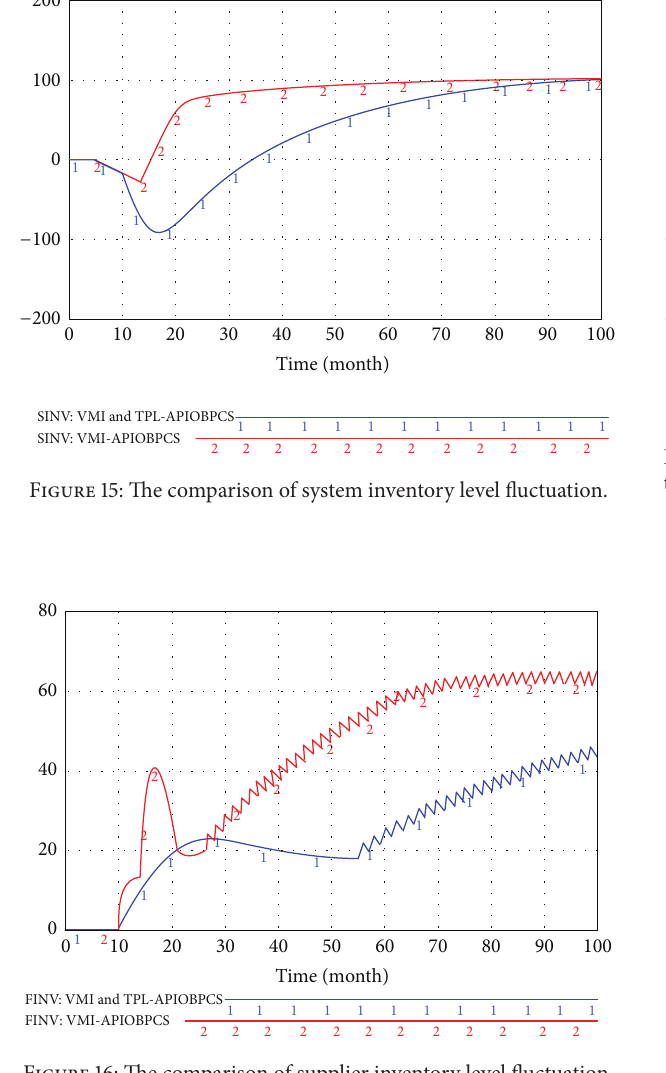
Figure 16: The comparison of supplier inventory level fluctuation.